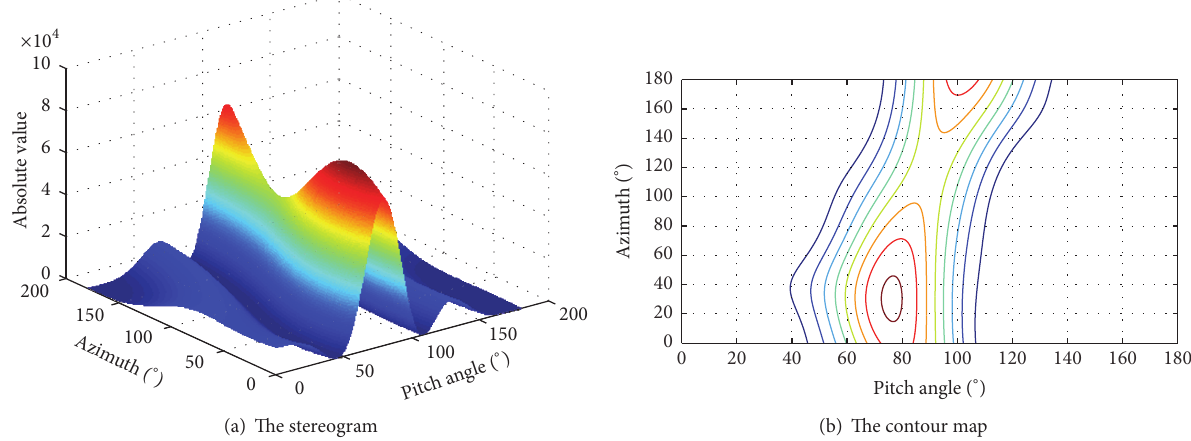
Figure 8: The scatter gram of the absolute value of the inner product in the space at position 3.